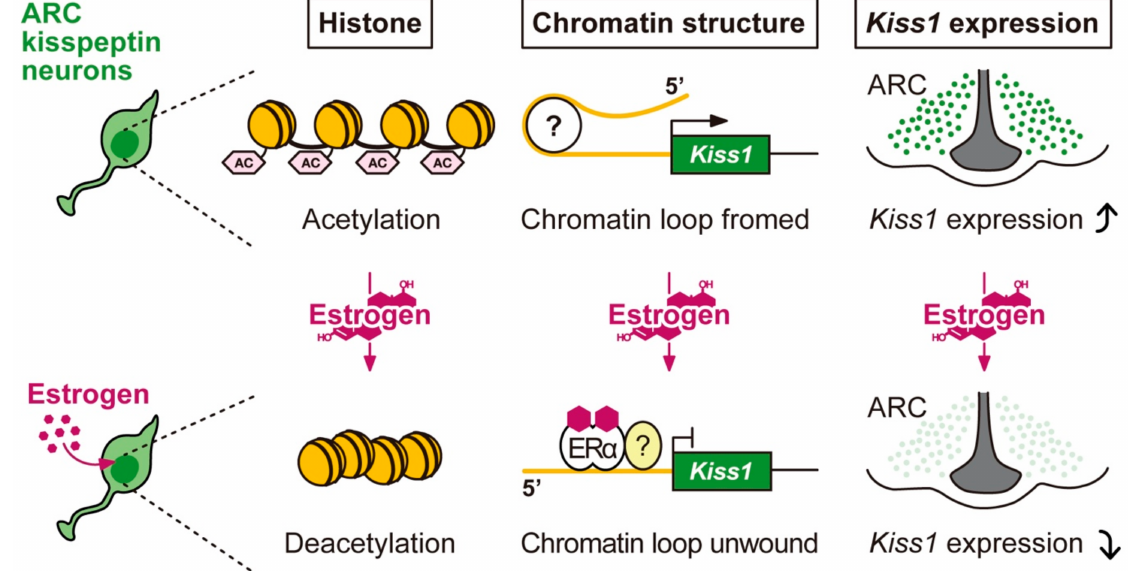
Figure 2. Putative molecular mechanism of the negative feedback action of estrogen on Kiss1 expression in the arcuate nucleus (ARC). Circulating estrogen seems to act on ARC kisspeptin neurons, in which estrogen-bound estrogen receptor α (ER α ) coupled with an unknown transcriptional partner may repress Kiss1 expression via histone deacetylation and unwinding chromatin loops between the Kiss1 promoter and the 5 (cid:48) -intergenic regions of Kiss1 locus. In the absence of estrogen, ARC Kiss1 expression may be up-regulated by histone acetylation and chromatin loop formation between the Kiss1 promoter and the 5 (cid:48) -intergenic regions of the Kiss1